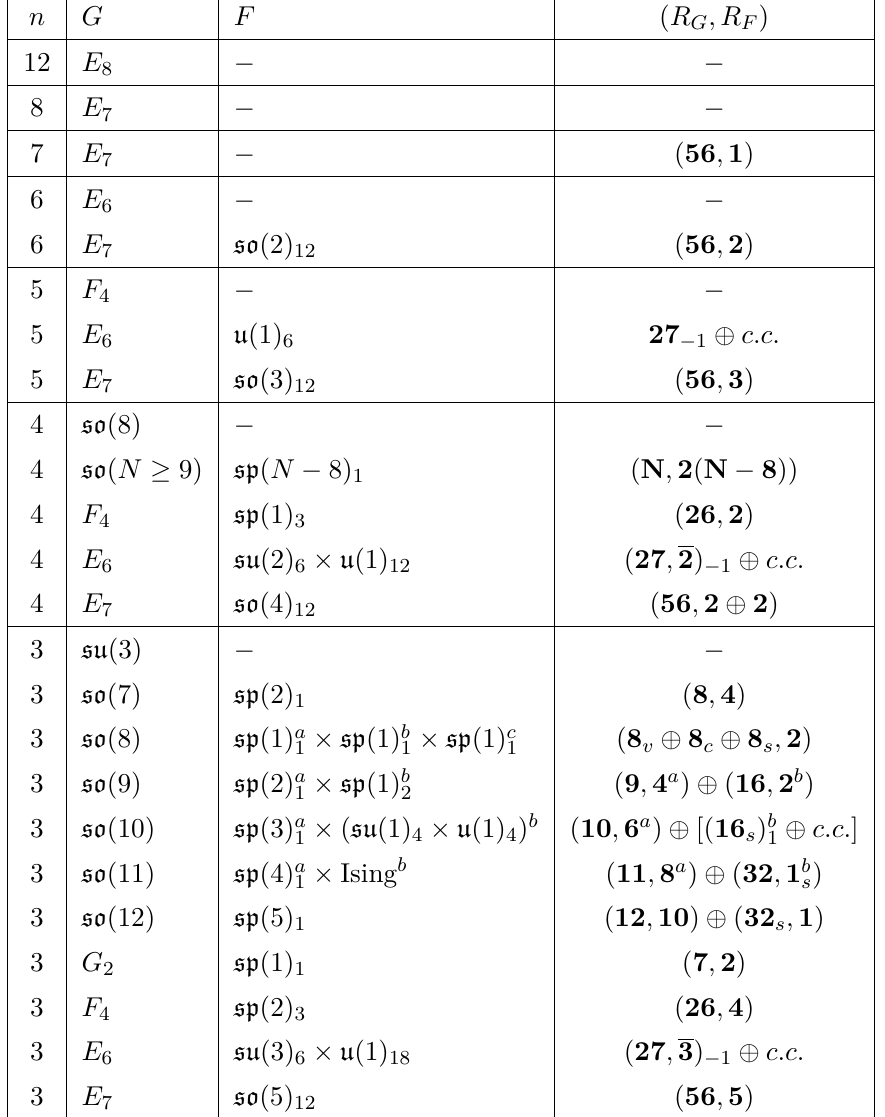
Table 2 . Gauge, flavor symmetries and charged matter contents of rank one 6d SCFTs with n ≥ 3 [1]. The subscript in a flavor symmetry algebra indicates the level of the associated current algebra. When a flavor symmetry has multiple simple components, superscripts are used to distinguish them and their representations. Matters are presented as the gauge and flavor representations by which the half-hypermultiplets transform. If there is an Abelian flavor symmetry, the Abelian charge is given as